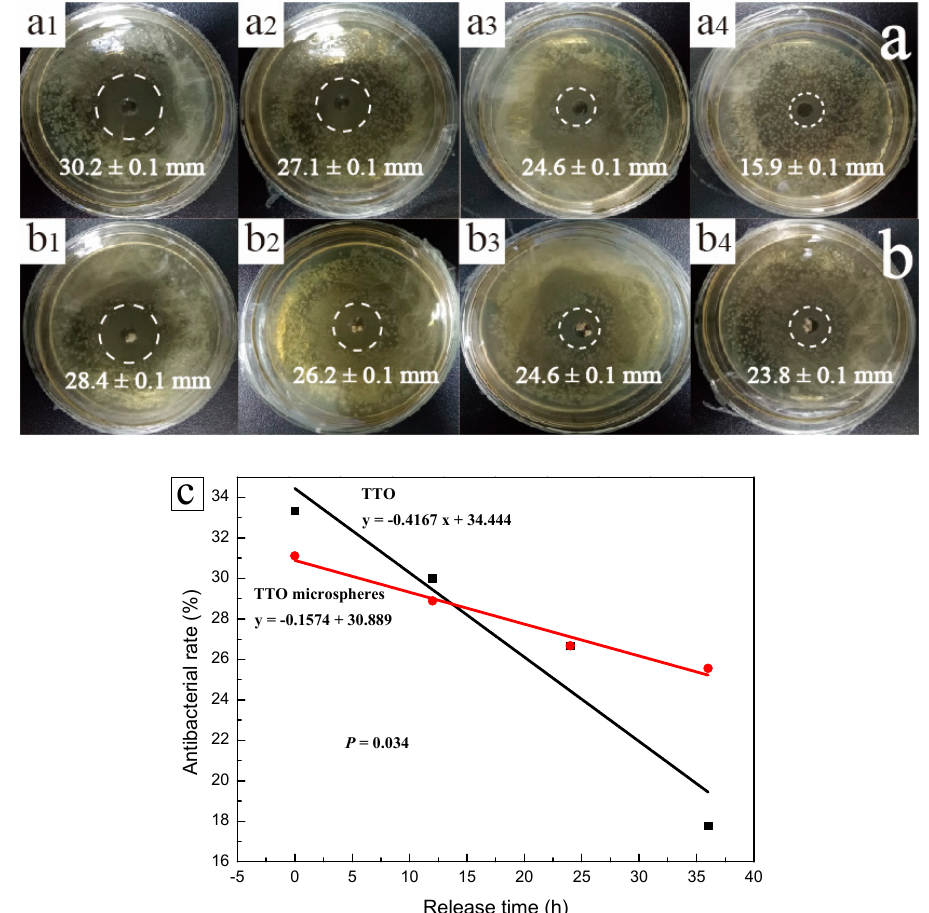
Figure 7. ( a ) Inhibition zones of TTO at various release times 0 h ( a 1 ), 12 h ( a 2 ), 24 h ( a 3 ), and 36 h ( a 4 ); ( b ) inhibition zones of TTO microspheres at various release times 0 h ( b 1 ), 12 h ( b 2 ), 24 h ( b 3 ), and 36 h ( b 4 ); and ( c ) anti-bacterial rate of TTO and TTO microspheres at various release